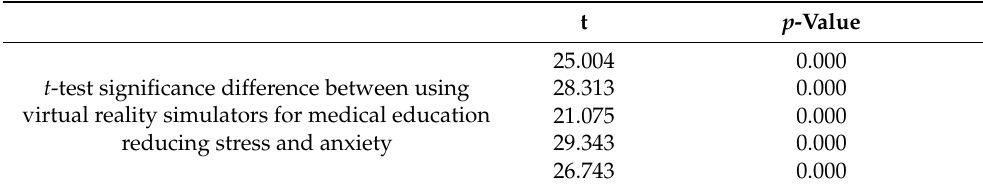
Table 6. T -test significance difference between using virtual reality simulators for medical education reducing stress and anxiety among the respondent. One-sample test: test value = 3. t p -Value t -test significance difference between